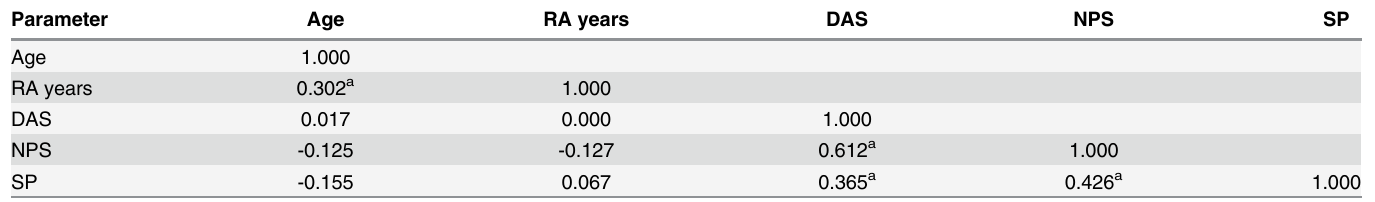
Table 2. The results of analysis of correlation on the Spearman rank test between SP, chronic pain in NPS, DAS, age and time of disease in years.